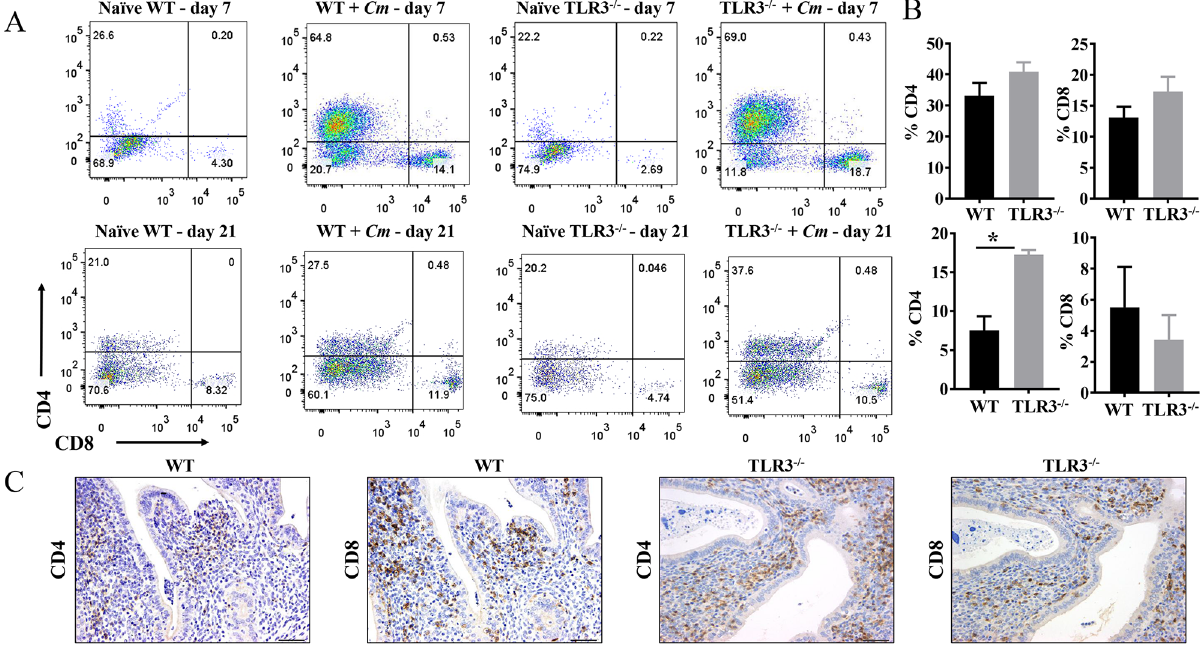
Fig 5. CD4 + and CD8 + T-cells recruitment into genital tracts of infected wild-type and TLR3 -/- mice. A) Groups of C57BL/6 and TLR3 -/- mice were infected intravaginally with 1 × 10 5 C . muridarum . At day 7 and day 21 post-challenge, reproductive tracts from each group of mice were harvested, and lymphocytes were isolated as described in Materials and Methods. FACS plots showing percentage of CD4 + and CD8 + cells within the CD3 + T-cell population (gated on CD3 + CD4 + or CD3 + CD8 + ) in the genital tract of a mouse from each group. FACS data showing representative results from each group of mice at days 7 and 21 of chlamydial infection . B) The percentages of CD4 and CD8 T-cells from each group were summarized in the graphs. Data shown are representative results from two independent experiments with three to five mice per time point. Bar graphs show mean number ± SEM. (cid:3) indicate P values of < 0.05 . C) Immunohistochemical staining of lymphocytes with antibodies to CD4 or CD8 in the genital tract of an infected mouse at day 21 of infection. Brown stain indicates CD4 or CD8 positive cells. Original magnification ×200 .